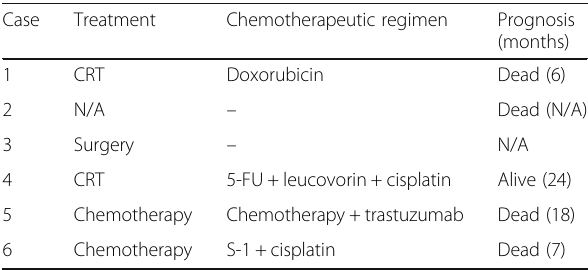
Table 2 Treatment and outcomes of the six reported cases of metachronous skeletal muscle metastasis after curative